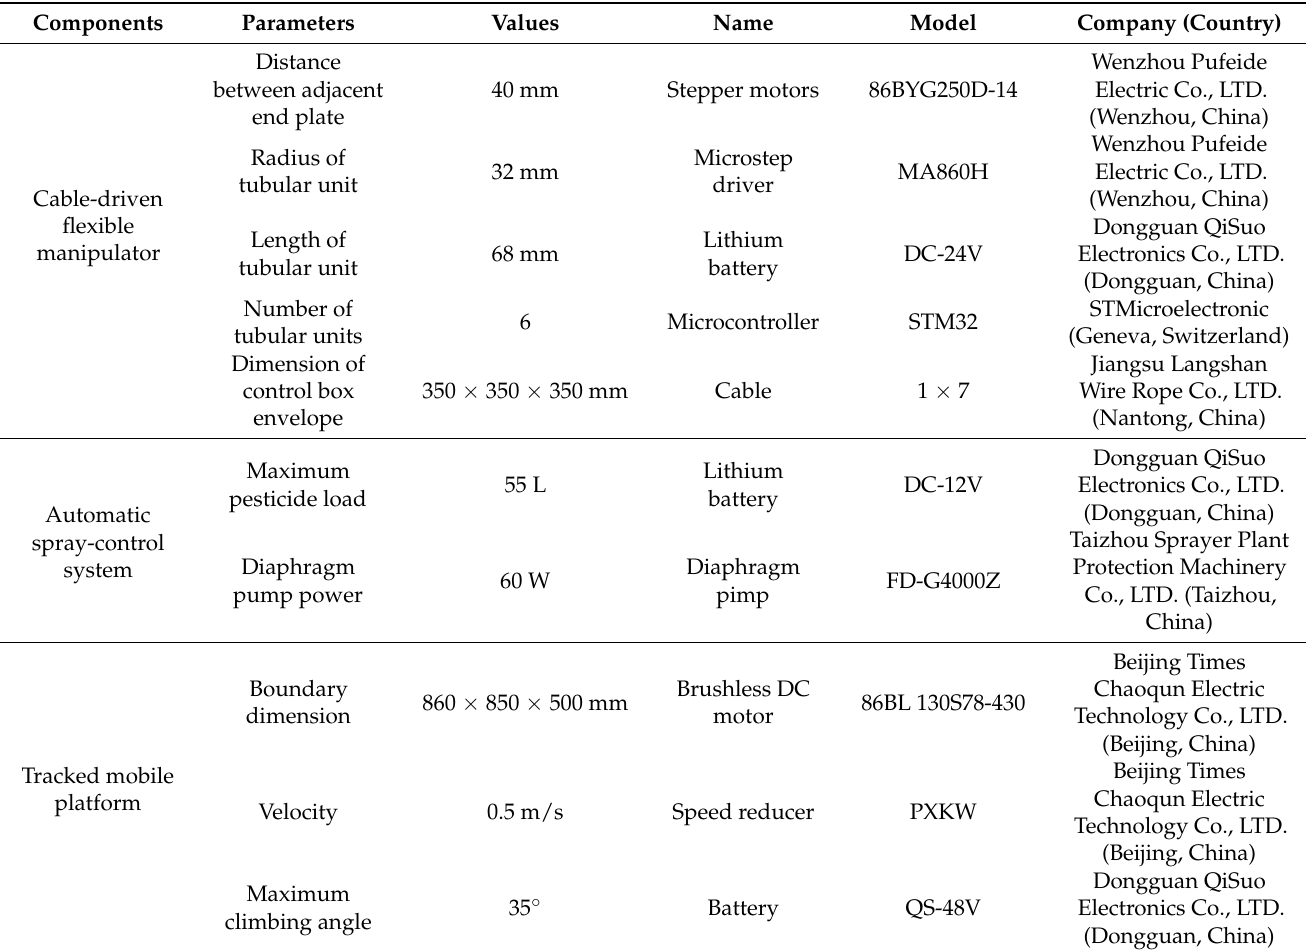
Table 3. Main technical parameters of the